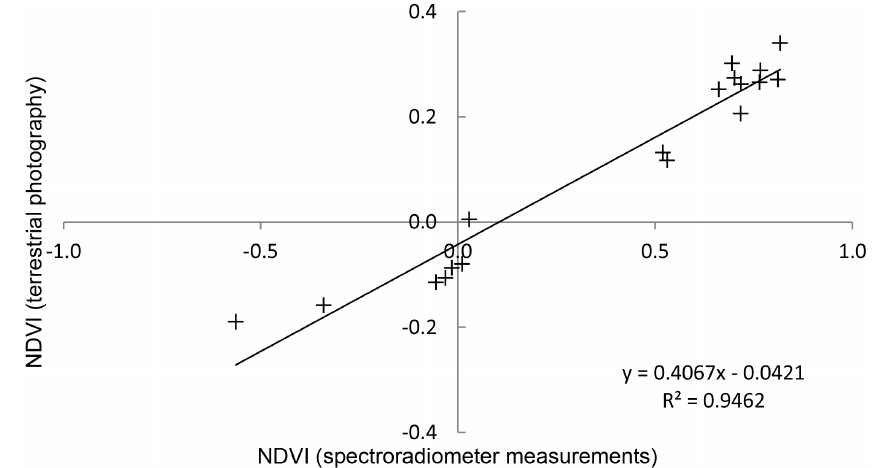
Figure 4. Comparison of NDVI computed from spectroradiometer field measurements and from terrestrial photographs for 18 control points in September 2014.